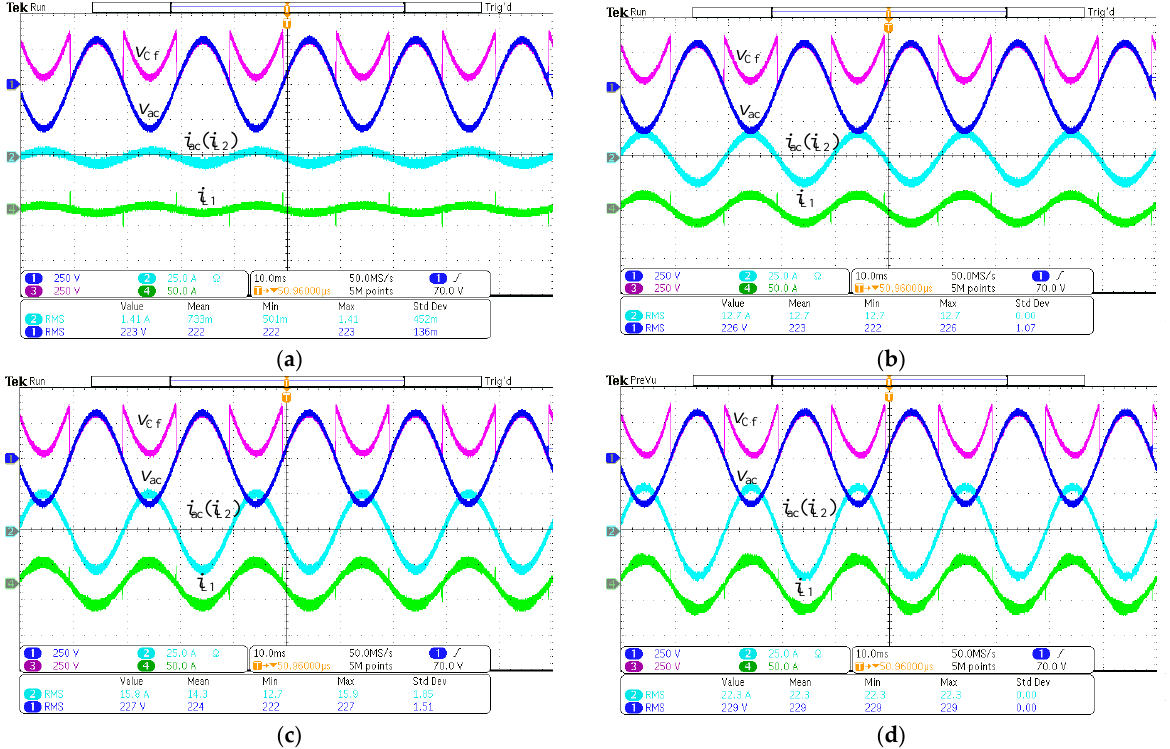
Figure 12. Steady-state waveforms of PFC at Inverter mode. ( a ) 0.5 kW, ( b ) 1 kW, ( c ) 2.5 kW, and ( d ) 5 kW.